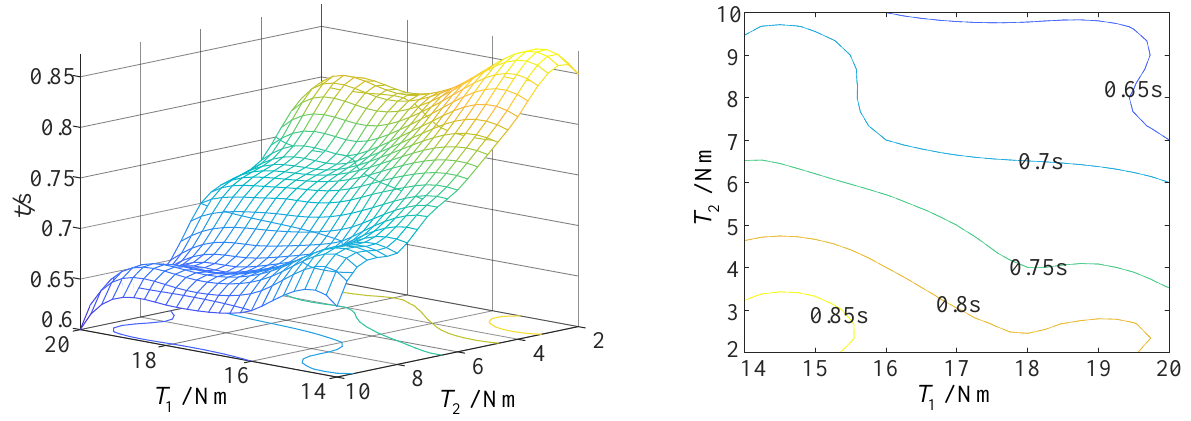
Figure 14. The curve of driving torque and deployment time of folding wing at an airspeed of 30 m/s (synchronous deployment mode).